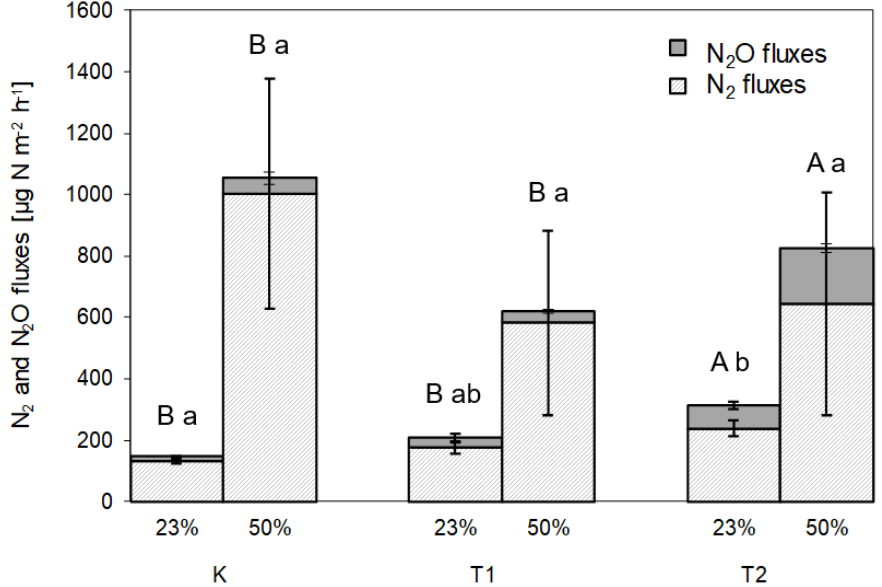
Figure 3. Mean N 2 and N 2 O fluxes at 23% and 50% water-filled pore space (WFPS) at 24 °C. Error bars represent the standard error of mean; n = 3. Capital letters show significance levels for N 2 O fluxes and lowercase letters for N 2 fluxes. The same letters are not significantly different at p < 0.05. N 2 :N 2 O emission ratios were similar for all treatments before the application of BC- compost mixtures at T1 and T2 and varied between 8.1 and 9.8 (data not shown). The ratio increased to 38.3 ± 50 (K) and 14.8 ± 12.9 (T1) but decreased at T2 under saturated soil conditions to 3.3 ± 2.8. After the application of additionally fertilized with BC-compost (T2), the ratio decreased to 3.3 ± 0.4 even at low WFPS. Since soil temperature did